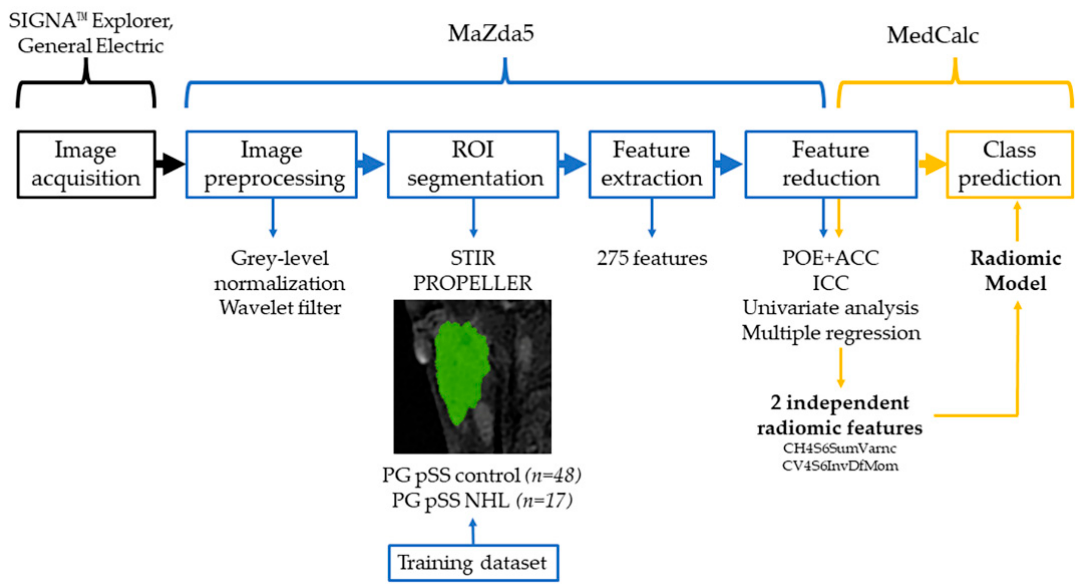
Figure 3. Radiomics workflow diagram. ROI = region of interest; STIR PROPELLER = short tau inversion recovery with periodically rotated overlapping parallel lines with enhanced reconstruction; PG = parotid gland; pSS = primary Sjögren’s syndrome; NHL = non-Hodgkin lymphoma; POE + ACC = probability of classification error and average correlation coefficients; ICC = Intraclass Correlation Coefficient, SumVarnc = Sum Variance; InvDfMom = Inverse Difference Moment.